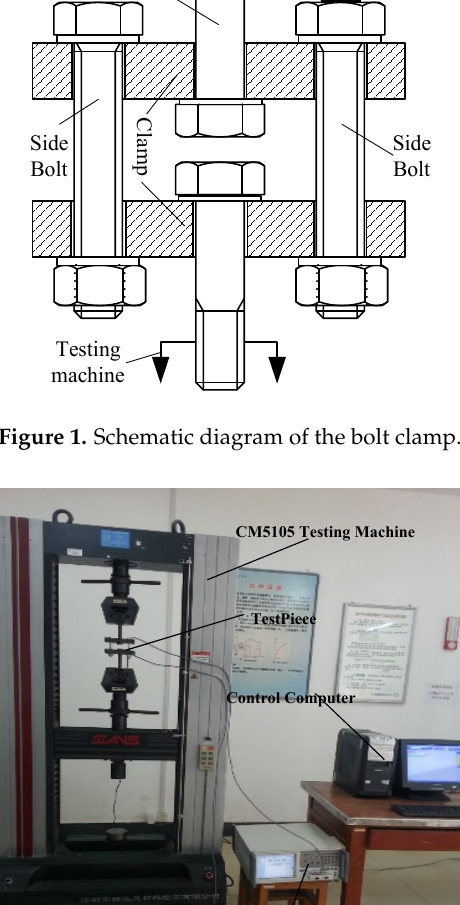
Table 1. Parameters of